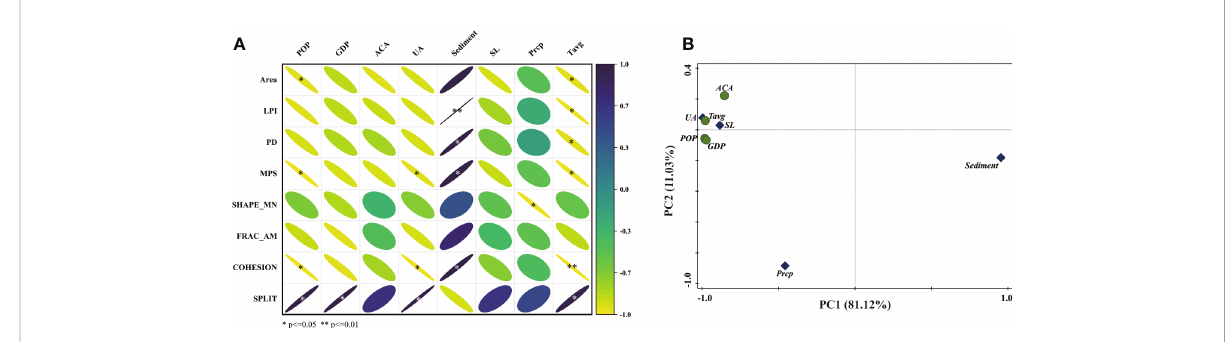
FIGURE 7 Relevant analysis results. (A) Correlation coef fi cient thermodynamic diagram of landscape characteristics of tidal fl ats and driving factors (* p<=0.05, ** p<=0.01). (B) PCA analysis of driving factors on mud fl at landscape patterns.